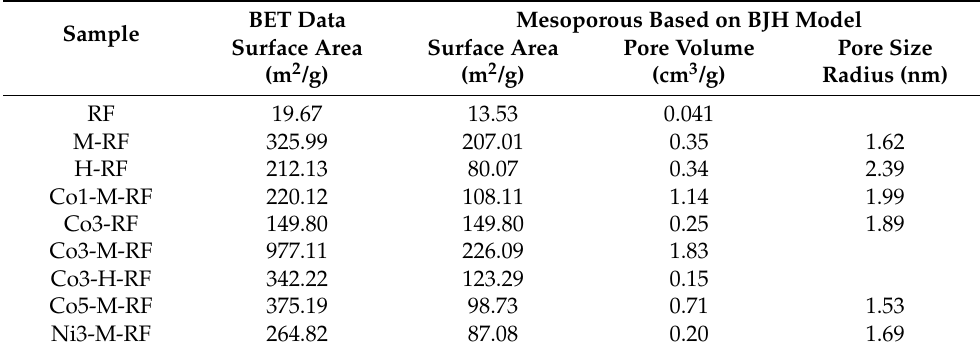
Figure 2. N 2 adsorption/desorption isotherms of ( a ) RF with varying PEI concentration (0%, 1.96% and 3.98% by weight), ( b ) MRFs with varying cobalt concentrations (0%, 1%, 3% and 5% Co (III) acetylacetonate by weight, ( c ) Cobalt doped RF made with varying PEI (1.96% and 3.98%) and Cobalt concentration (0%, 3% and 5% Co(III) acetylacetonate by weight), and ( d ) Metal -doped M-RF with 3% Co (III) acetylacetonate by weight and 3% Ni(II) acetylacetonate by weight. Table 2. Surface area and pore size distributions of various catalyst based on BJH model. (Standard deviation was within ( ± 3–4%) of the average